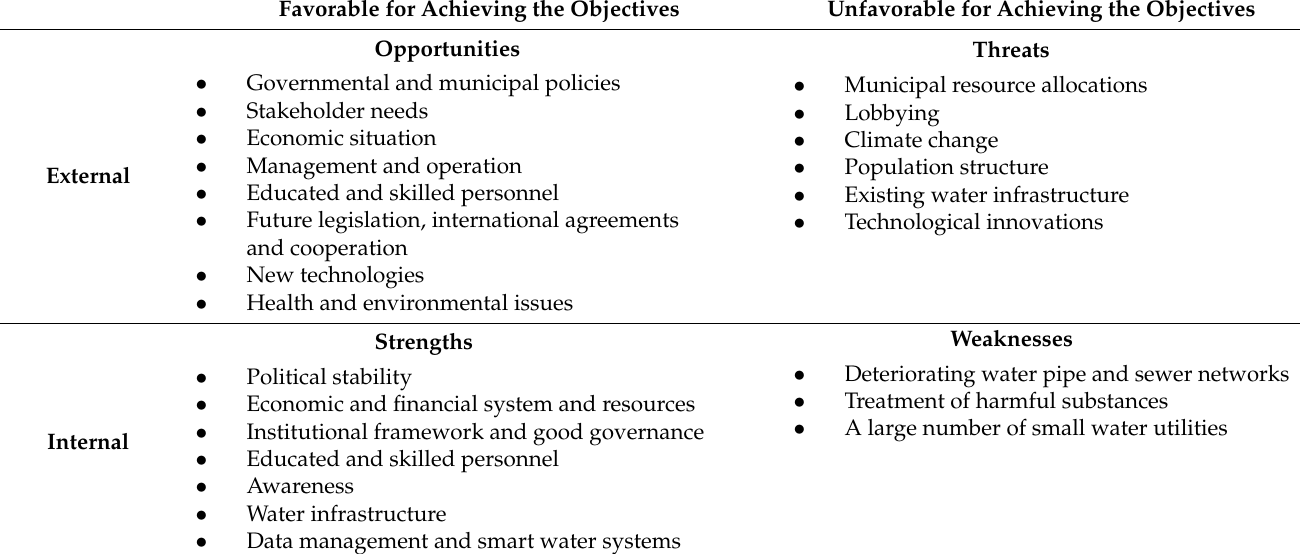
Table 1. SWOT table of ‘Sustainable and resilient urban water services from the point of view of water